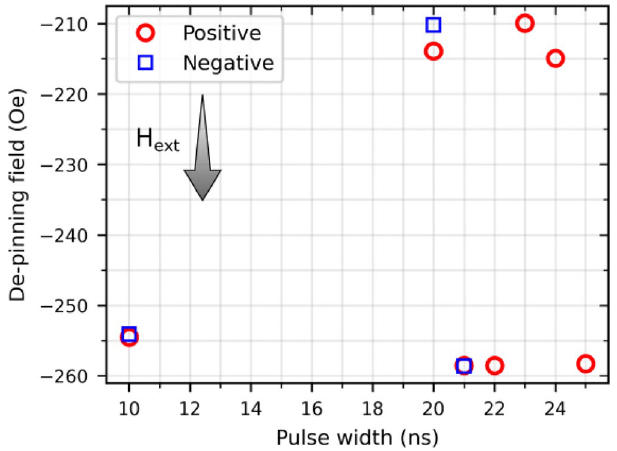
Figure 5. De-pinning field observed after applying pulses of 1 × 10 12 A/m 2 and different pulse widths and polarities. For pulse widths longer than 22 ns, negative pulses induce the de-pinning of the DW and no de-pinning field is